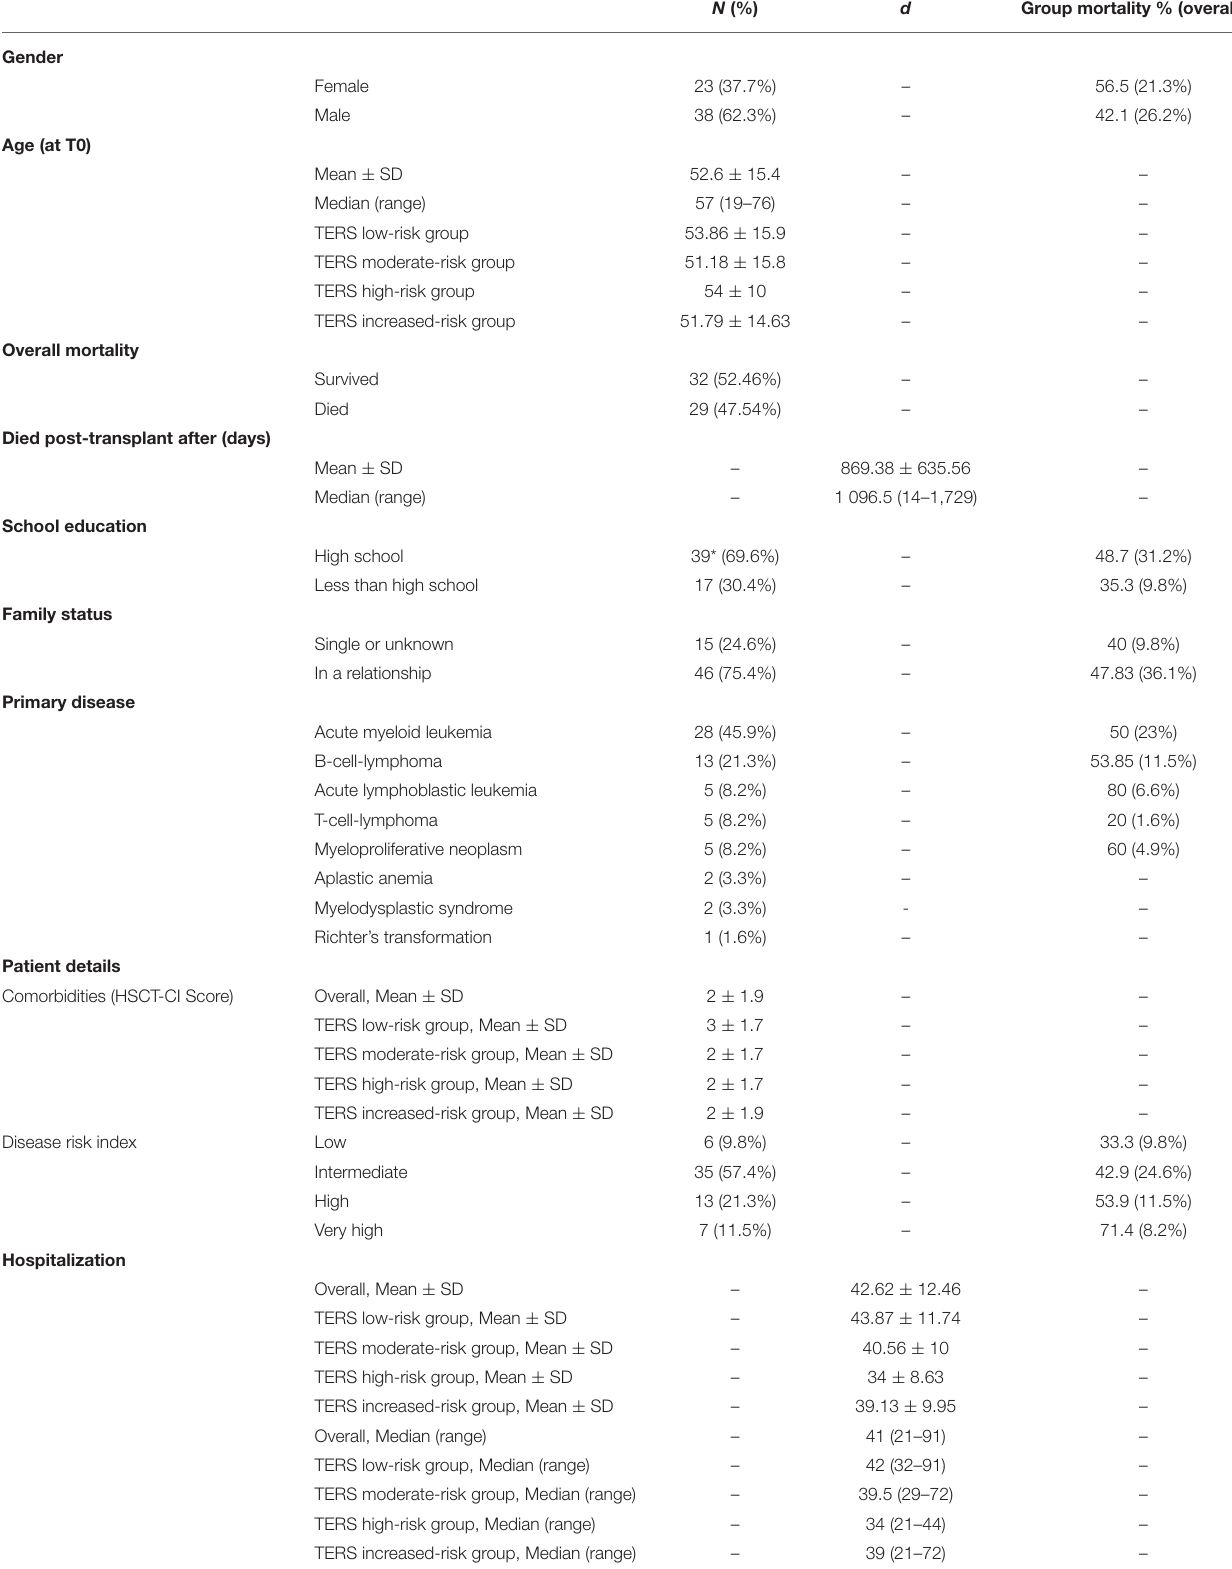
TABLE 1 | Patient